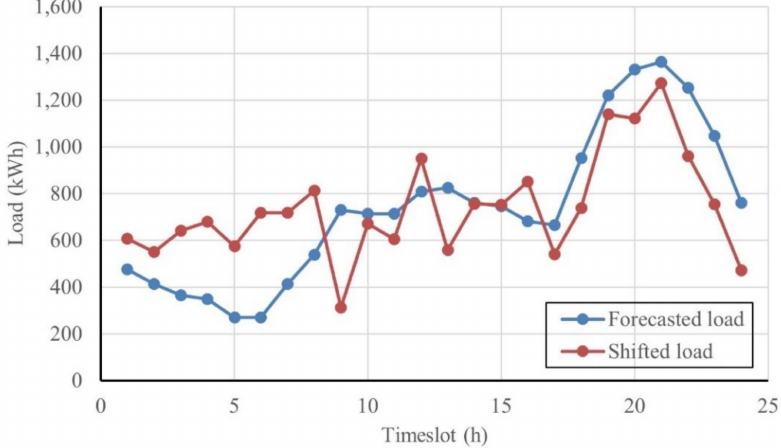
Figure 14. Hourly residential load before and after DSM using the distributed algorithm